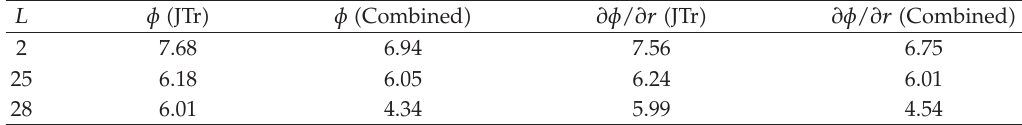
Figure 9: Comparisons of convergence rates of the sixth-order compact schemes for the sample geodynamo problem. Results were obtained separately from the Jacobian transformation and the combined method at L (cid:9) 2: solution error φ (cid:6) a (cid:7) ; derivative error ∂φ/∂r (cid:6) b (cid:7) . Table 1: A summary of the convergence rates for the state variable φ and its derivative ∂φ/∂r at di ff erent values of L